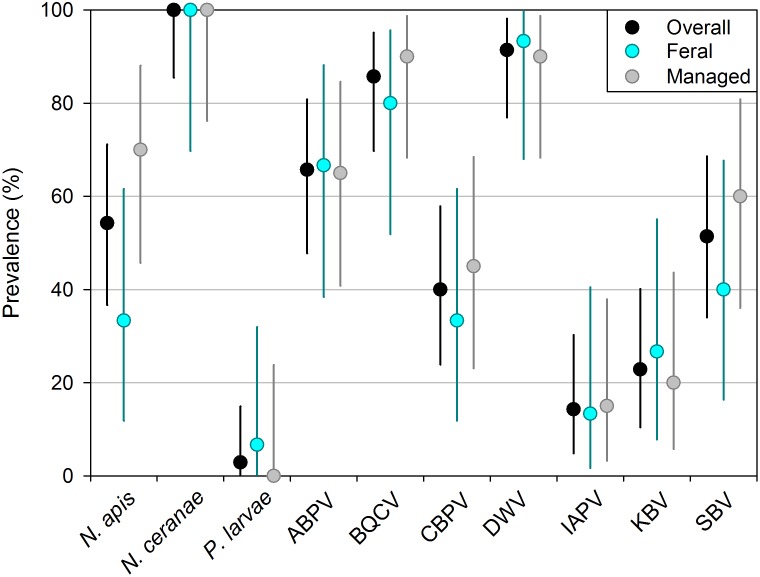
Prevalence of 10 honey bee pathogens in our whole sample and in the feral and managed subsets.Error bars are exact 95% confidence intervals and disease abbreviations are as in Fig 2.